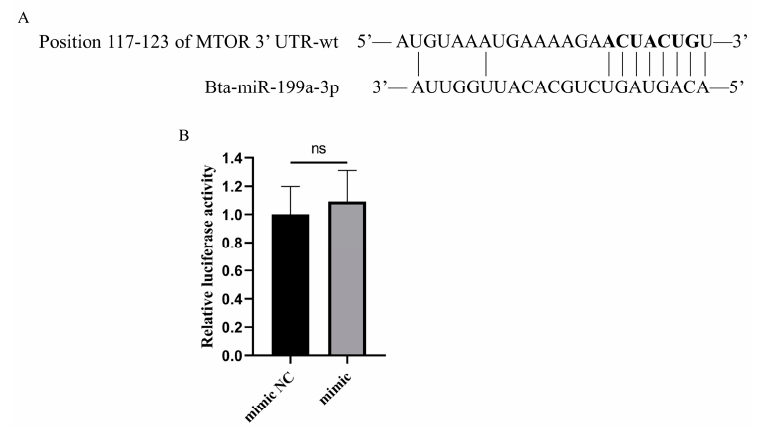
Figure 6. MTOR is not a molecular target of bta-miR-199a-3p. ( A ) TargetScan and miRWalk predicted the binding site of bta-miR-199a-3p to MTOR 3 (cid:48) -UTR. ( B ) The results of double luciferase activity detection. The miR-199a-3p mimic or mimic NC and the wild-type MTOR 3 (cid:48) -UTR luciferase reporter vector were co-transfected into 293T cells for double luciferase activity detection after 48 h. The relative luciferase activity on the ordinate represents the ratio of renilla luciferase activity to firefly luciferase activity. ns refers to p > 0.05.